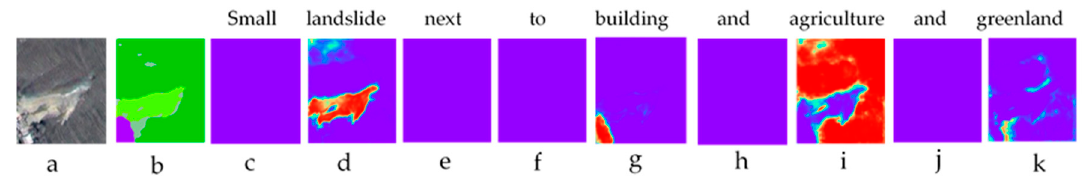
Figure 8. The weight focus matrix of each time.